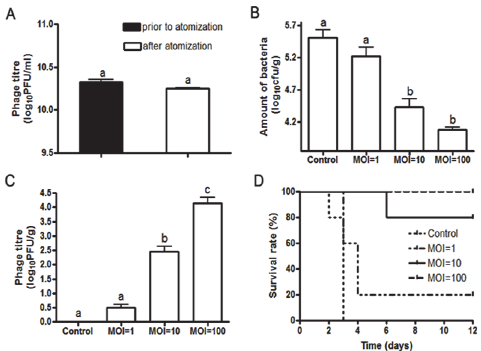
Figure 5. Phage PPA-ABTNL cures mink hemorrhagic pneumonia caused by a clinical P. aeruginosa strain. (A) Effect of atomization on the titer of phage. (B) Effect of different multiplicities of infection (MOIs) on the amount of bacteria in the lung of mink. (C) Effect of different MOIs on the amount of phage in the lung of mink. (D) Survival curves of mink infected with PA5-1-1 strain and treated with phage PPA-ABTNL. n = 5. Means with different superscripts differ significantly from each other (P <